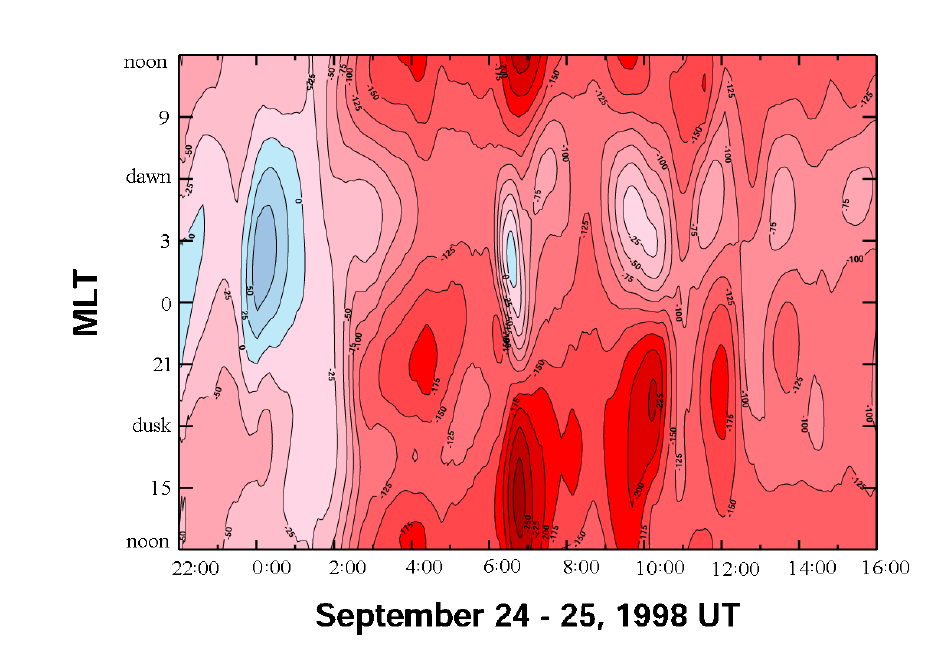
Fig. 8. Magnetic Local Time (MLT) versus Universal Time (UT) map showing the H component of the magnetic disturbance field obtained from middle- and low-latitude ground-based magnetometers on 24–25 September 1998. The effect from a quiet day (17 August) variation is removed. The contours show a magnetic disturbance at 25-nT intervals from the quiet-day variation, with positive perturbations shaded in blue and negative ones shaded in red.